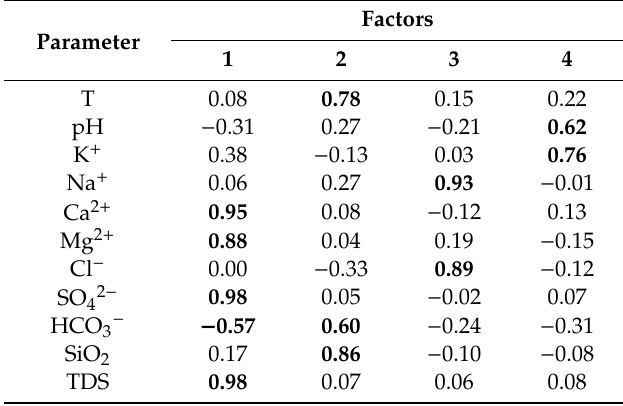
Table 4. Matrix of varimax rotated factors loading. Table 3. Eigenvalues and percent of variance for the factor analysis of the physico-chemical parameters.